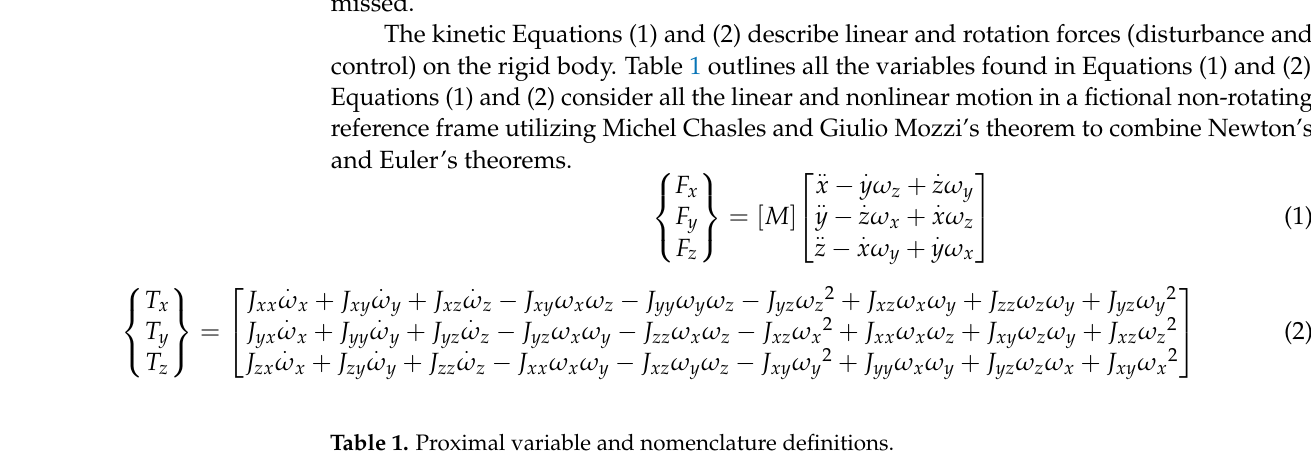
Table 1. Proximal variable and nomenclature